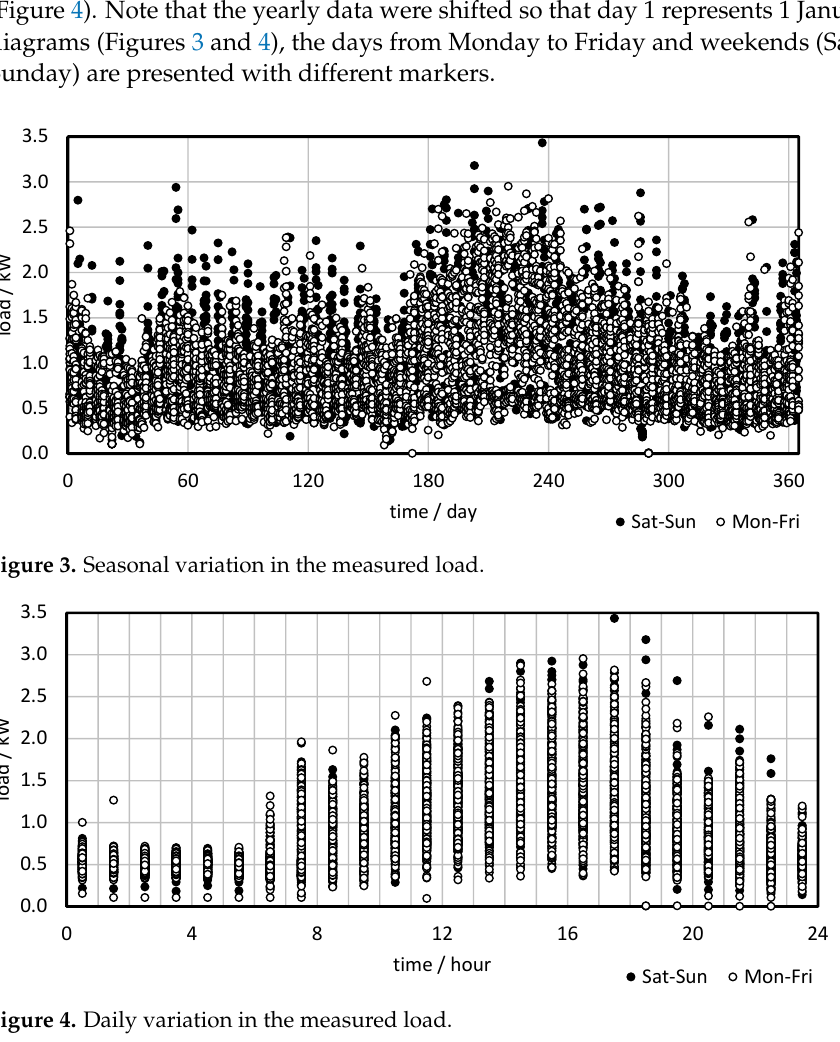
Figure 2. Monthly energy consumption and production with diesel generator.